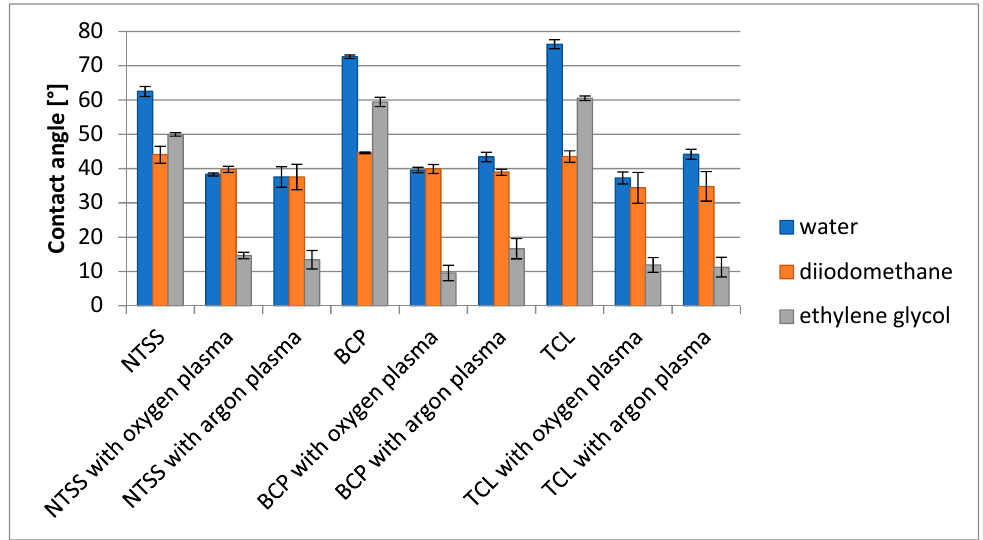
Figure 1. Contact angle of PLA film with water, diiodomethane, and ethylene glycol before and after plasma activation.